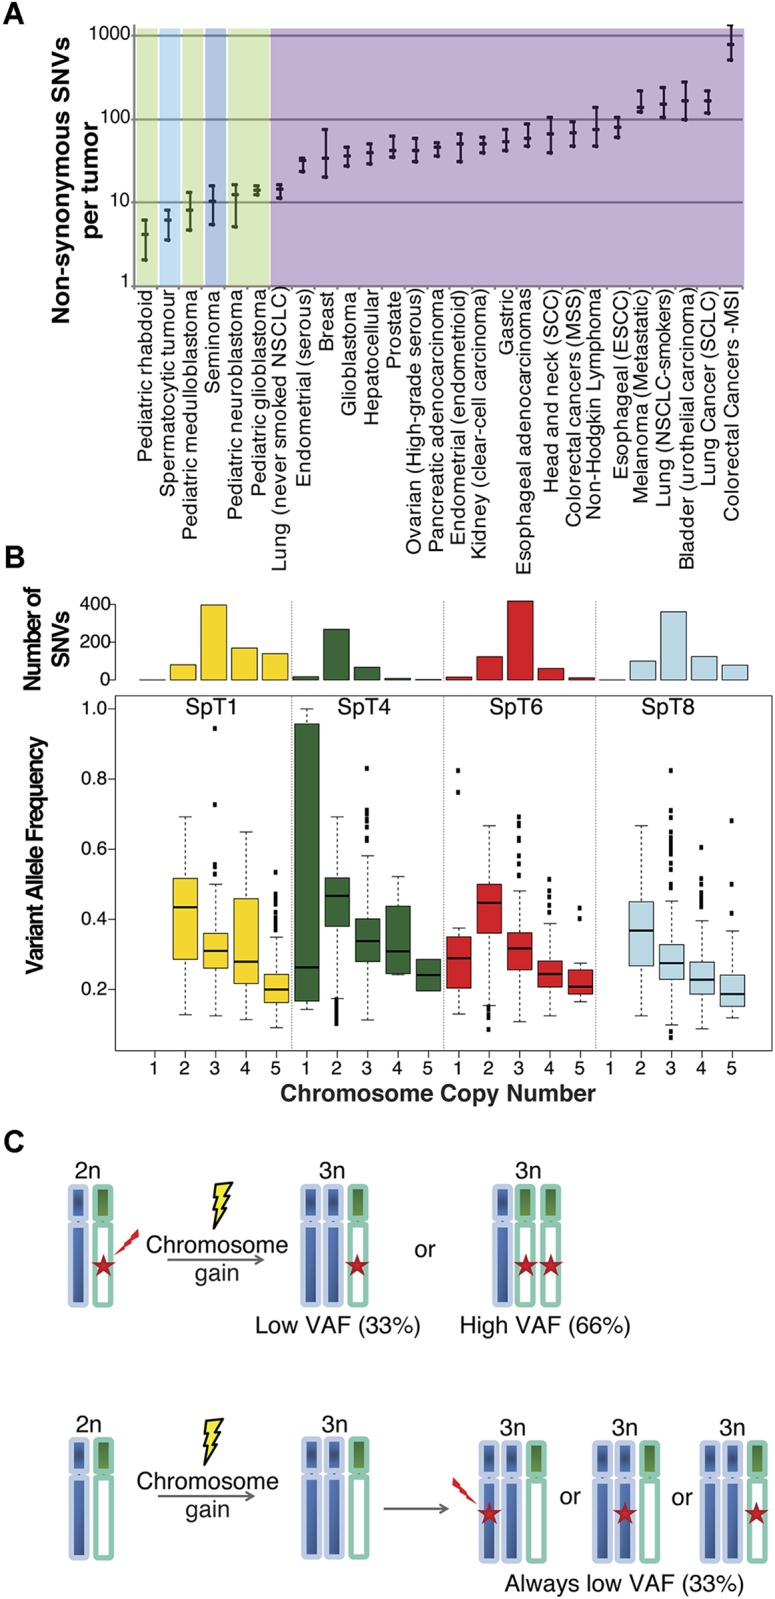
Single nucleotide variant analysis.(A) Mutation burdens in different tumor types. Compared to solid tumors with an adult age of onset (purple), SpT (light blue) have an extremely low number of non-synonymous SNV mutations, similar to pediatric cancers (green) and slightly lower than classical germ cell tumors (dark blue). Median values and interquartile range are presented. Data for other cancers from Vogelstein et al. 2013 [50]; Brabrand et al. 2015 [46]. (B) Box plots of the variant allele frequency observed in each SpT, binned by the copy number of the chromosome on which each SNV is located. Variant allelic ratios tended to be low (< 50%) and inversely correlated with the chromosome copy number on which they occurred (indicated at the bottom of the Figure). The total number of variants reported is shown as a bar plot at the top of the panel B. Allelic ratio data for non-synonymous SNVs are given in S3A Table; data for individual chromosomes are given for each tumor in S4 Table. (C) Schematic explaining the impact of mutational event order on expected variant allele frequency (VAF) in the case of (3n) chromosome number. In the upper panel, an SNV has occurred before the event of chromosome gain/duplication leading to trisomy. This will result in the observation of either high variant allele frequency (~66%) or low VAF (~33%) for the acquired SNV, depending which chromosome has been duplicated (green or blue, respectively). Assuming the SNV is a ‘passenger’ mutation, the two scenarios are anticipated to be observed with equal frequency; for a ‘driver’ mutation, the high VAF (66%) would be observed more commonly. In the lower panel, chromosomal gain/duplication has preceded the occurrence of the SNV. In this case, the VAF of the acquired SNV will always be observed at a low level (≤33%).